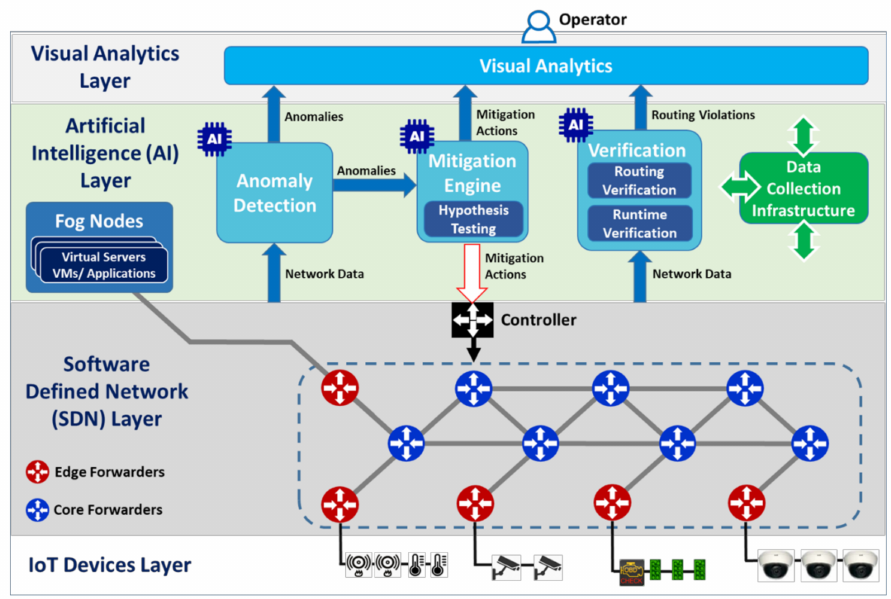
Figure 1. The architecture of the proposed system along with the SDN layer and the IoT devices